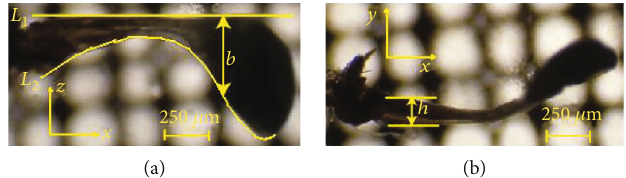
Figure 11: Image of the haltere along the (a) dorsal and (b) lateral sides.